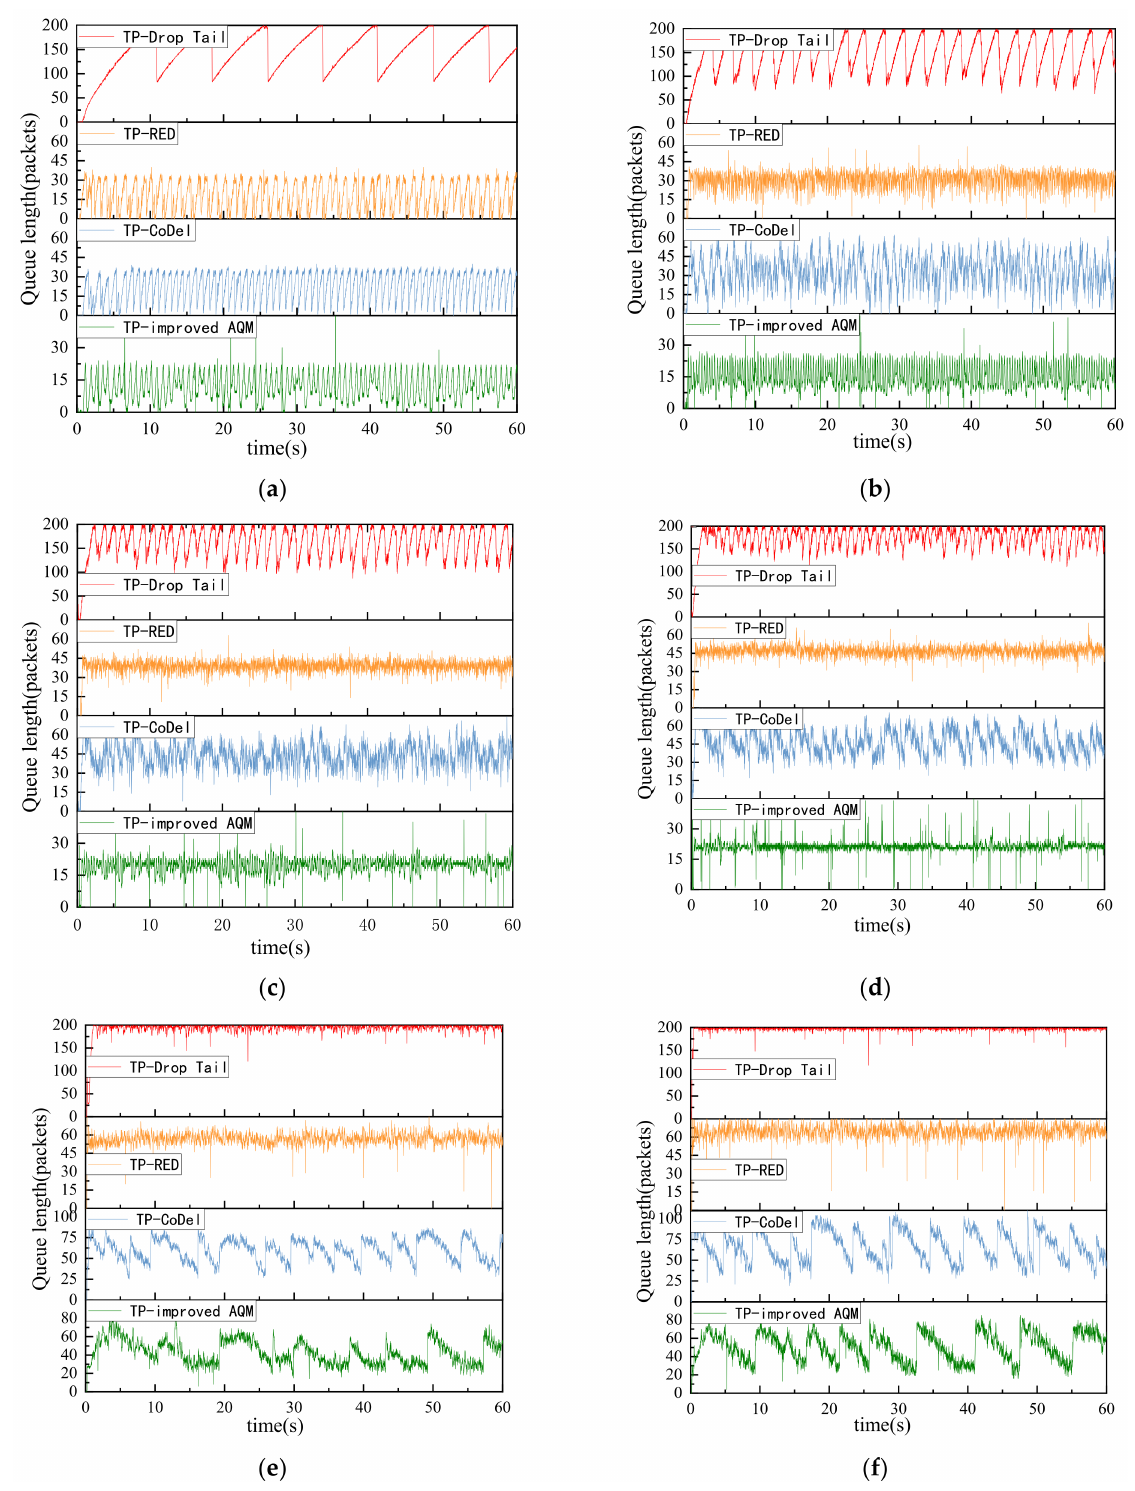
Figure 9. The queue length under different numbers of ICN flows: ( a ) 1 flow; ( b ) 3 flows; ( c ) 6 flows; ( d ) 9 flows; ( e ) 20 flows; ( f ) 40